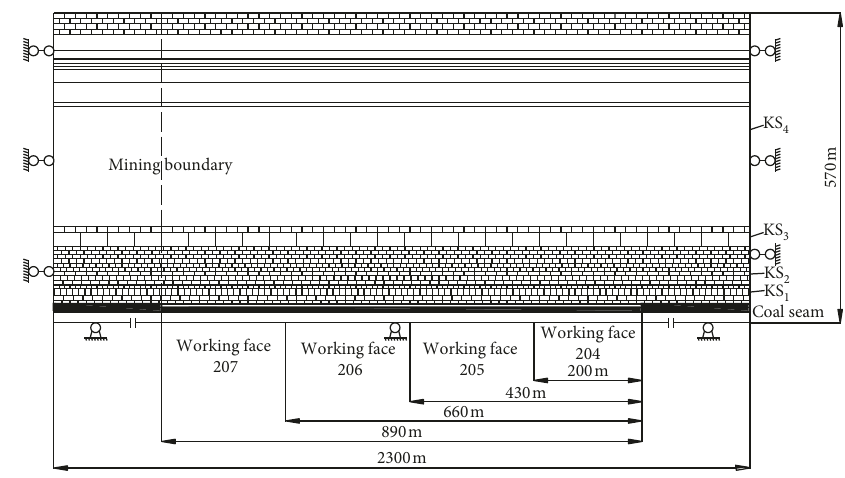
Figure 12: Model geometries. Table 3: Mechanical parameters of rock mass used in the numerical